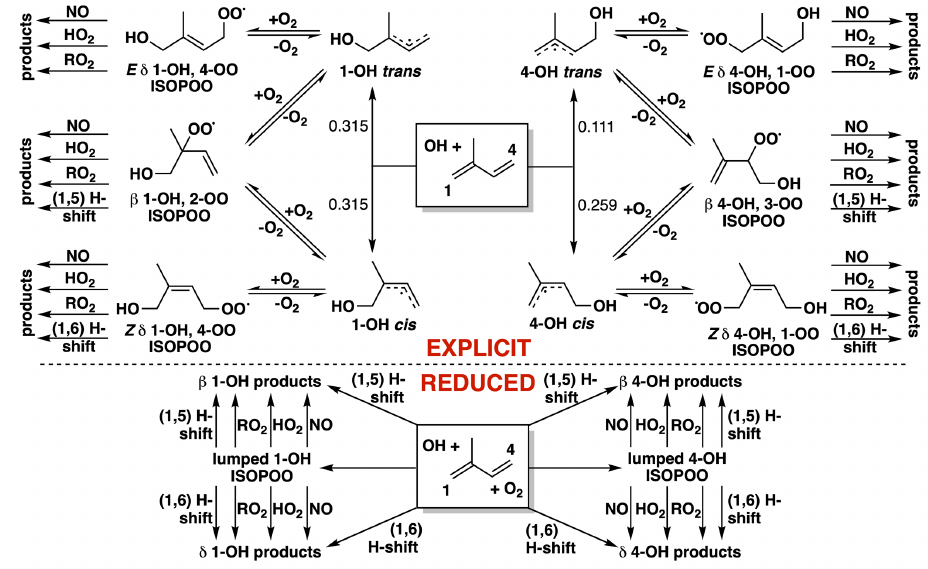
Figure 1. Fate of the allylic and peroxy radicals produced from the reaction of isoprene with OH in the presence of O 2 . The explicit Wennberg et al. (2018) scheme is on top, and the reduced Caltech isoprene mechanism (RCIM) scheme is on